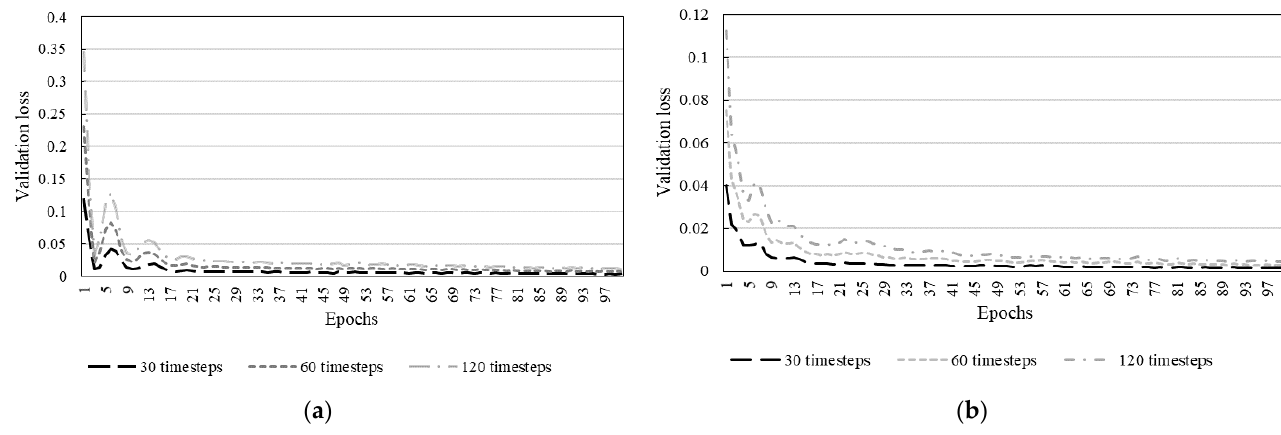
Figure 5. Model performance for ( a ) great recession and ( b ) COVID-19 pandemic during training for each timesteps.